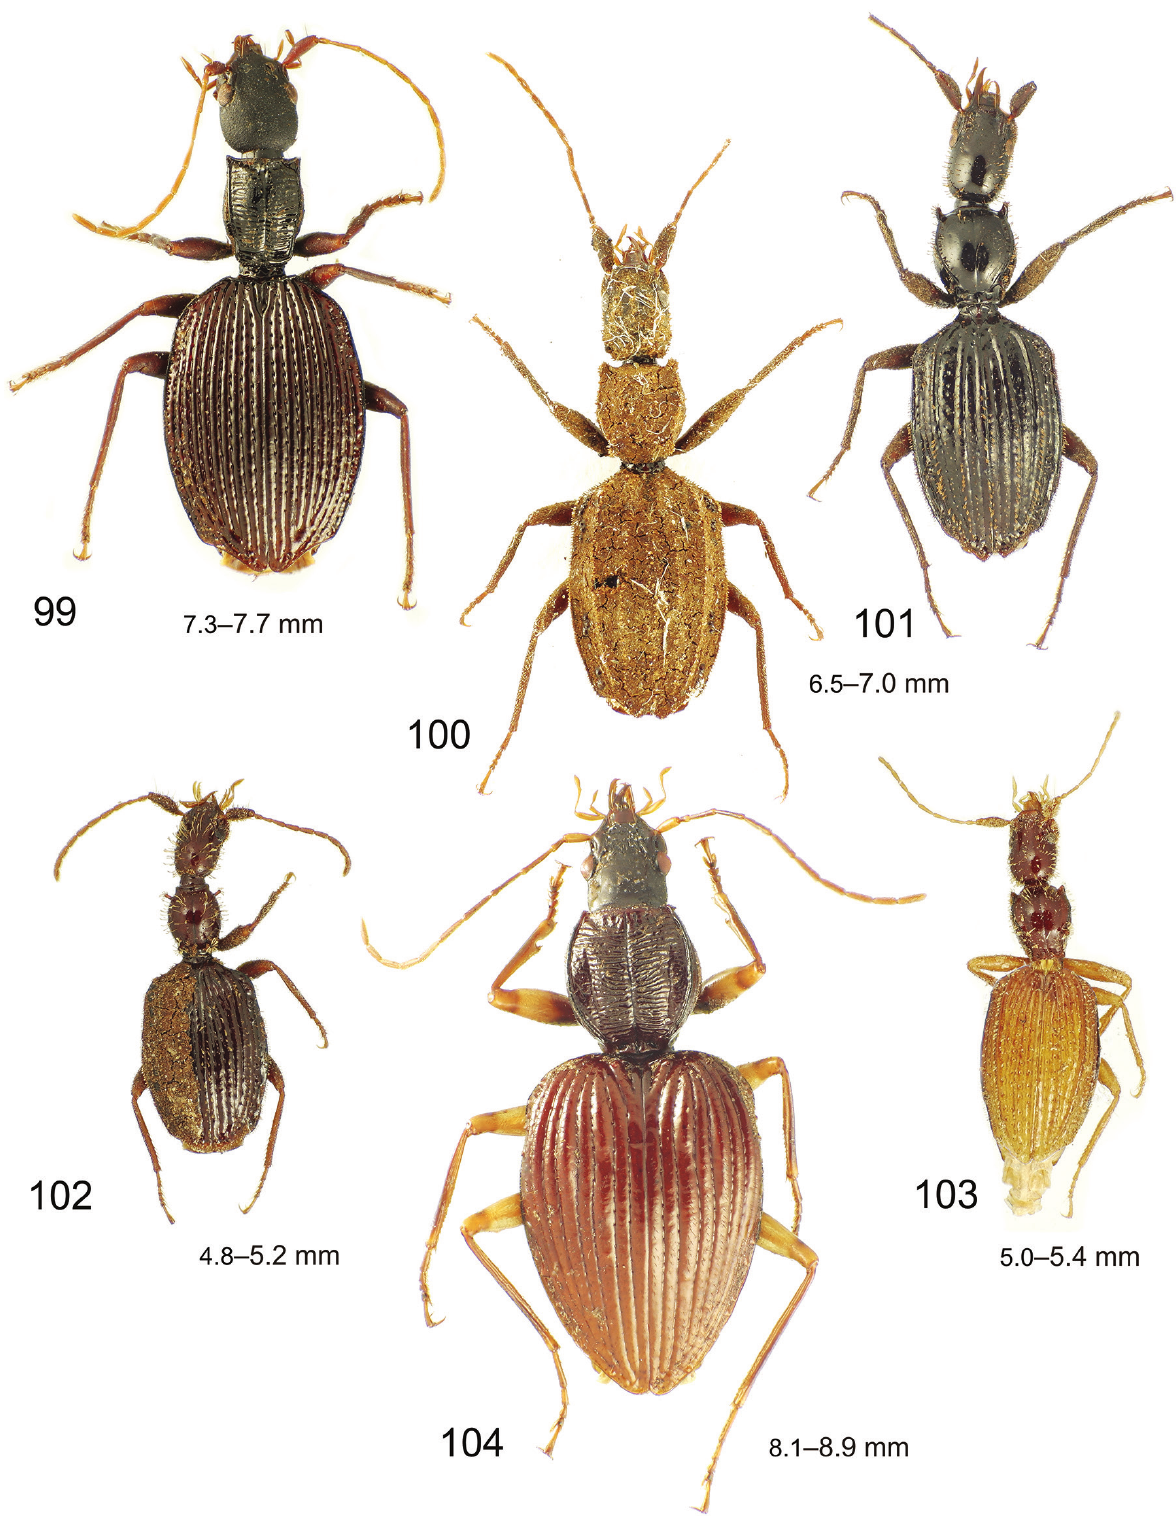
Figures 99–104. Dorsal habitus photographs of Cyphocoleus spp.: 99 , C. miricollis , Forêt Nord; 100 , C. mirabilis female, envi- ronmental patina intact, Mt. Koghi; 101 , C. mirabilis male, environmental patina removed, Mt. Koghi; 102 , C. moorei female, environmental patina removed from forebody and right elytron, E. Table Unio; 103 , C. lescheni female, environmental patina removed, elytra reassociated with dissected specimen, Aoupinié; 104 , C. fasciatus male, teneral specimen lacking environmental patina, Mt. Panié